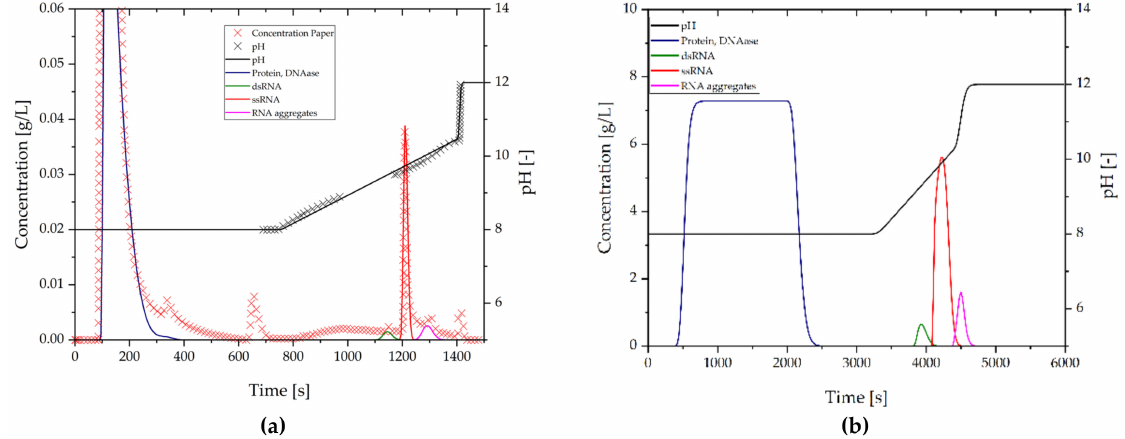
Figure 17. Comparison of the laboratory process ( a ) and the scaled-up process ( b ). The literature data is given as symbols, the simulated data is depicted as